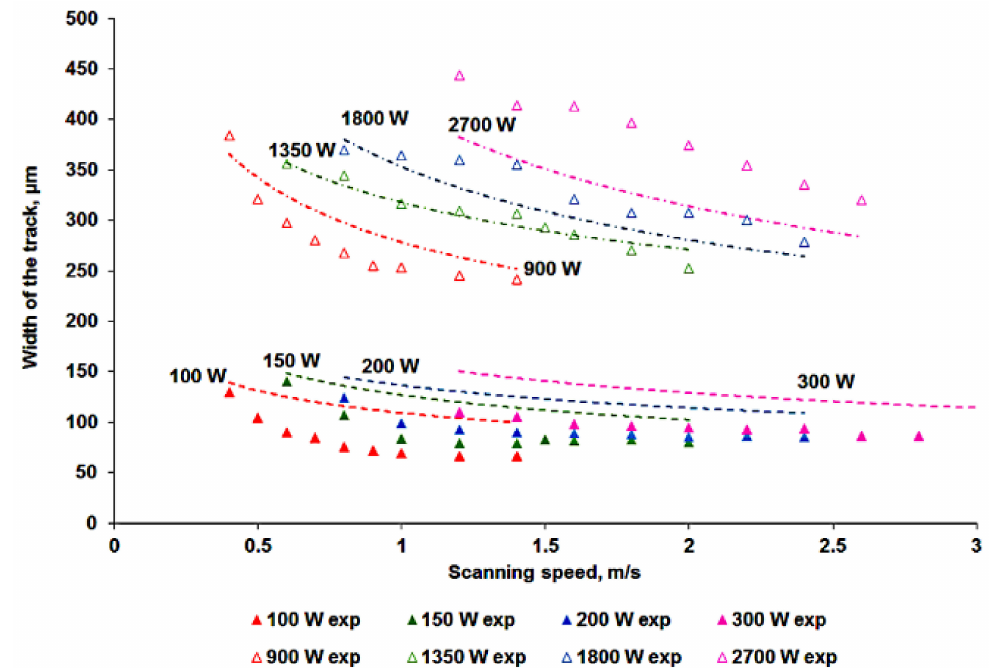
Figure 8. Experimental values (data points) and calculated width (dotted lines) of the tracks at different laser power and beam diameter versus scanning